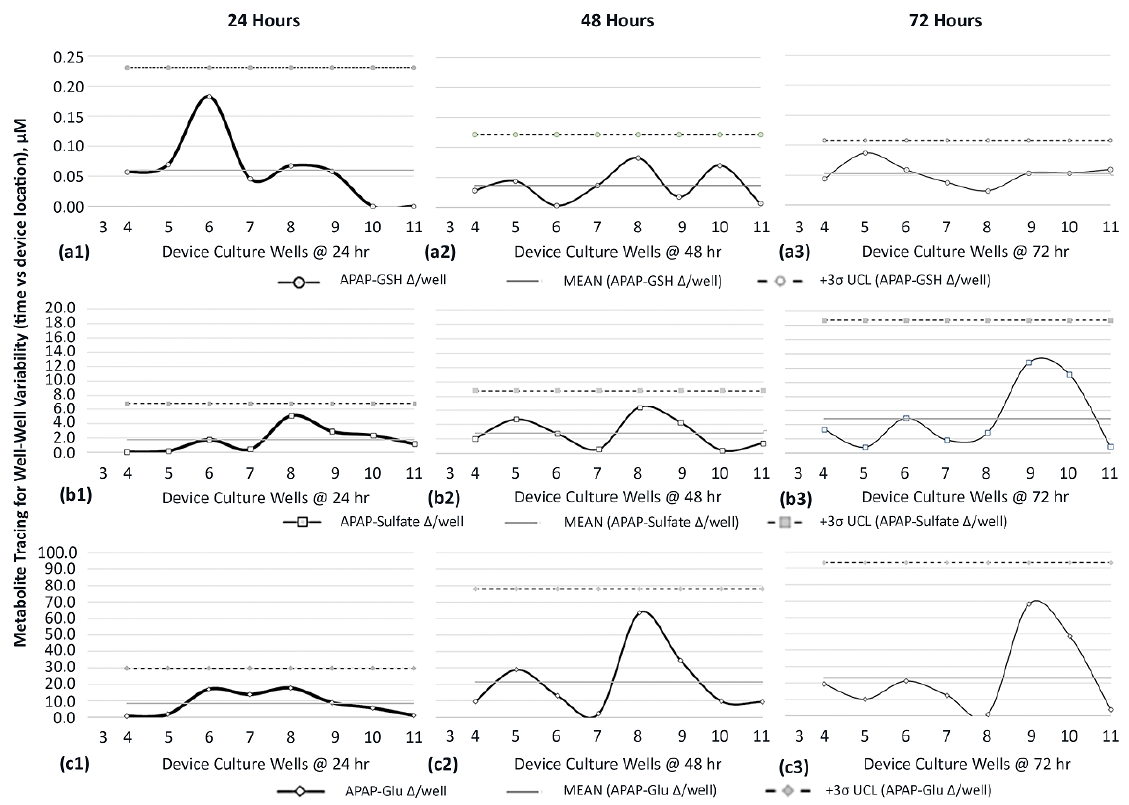
Figure 9. Surveillance of metabolite variability amid device multiwell locations 4–11 (n = 1), observed at 24 h, 48 h, and 72 h. MR is the concentration moving range ( ∆ ) between adjacent wells. Well 3 is devoid of an upstream adjoining well and precludes MR calculation. Metabolites are ( a1 – a3 ) APAP- Table 4. Summary of APAP-Metabolite variance from HepaRGs—generation and dissemination.